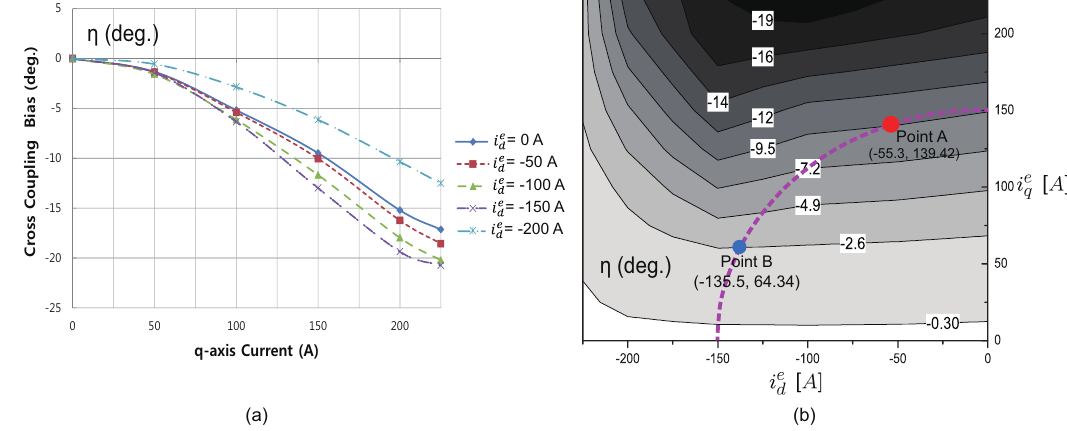
Figure 9. The cross-coupling bias η calculated based on the FEM data: ( a ) Plot of η and ( b ) contour plot of η